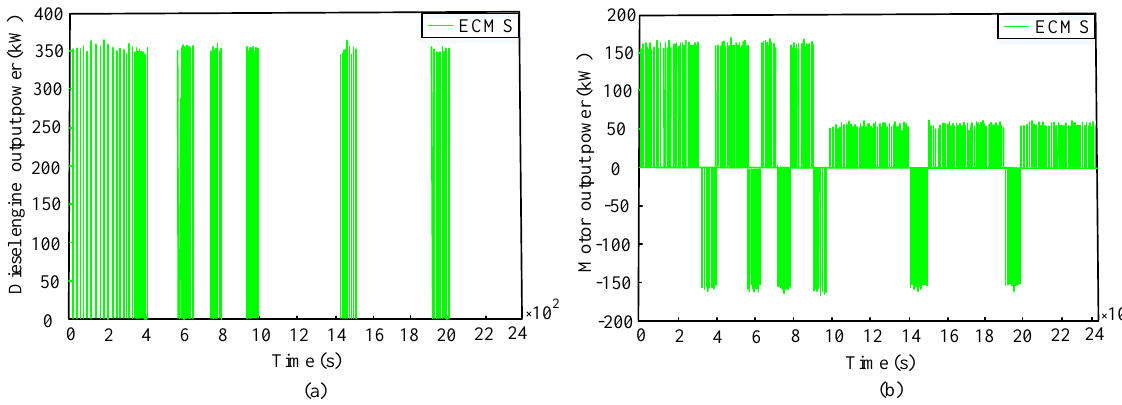
Figure 11. ( a ) Power distribution of ECMS strategy diesel engine under the T condition. ( b ) Power distribution of ECMS strategy motor under combined condition.